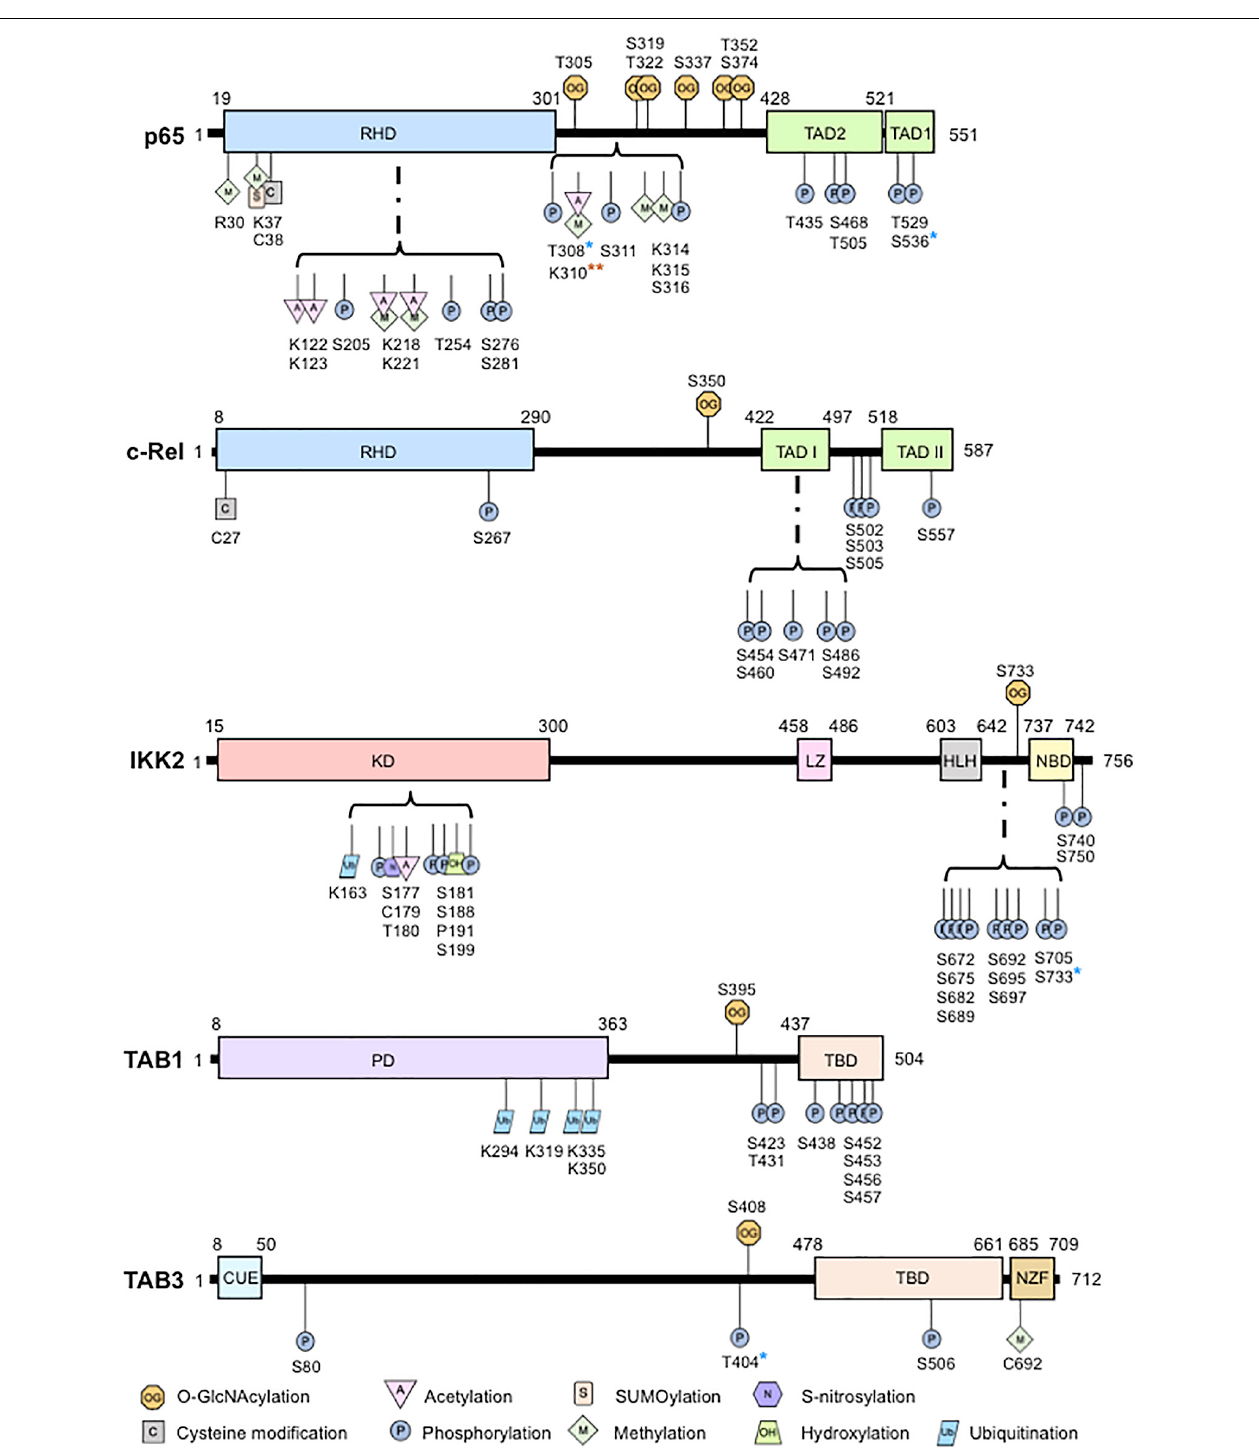
FIGURE 1 | Overview of O -GlcNAcylation sites and other posttranslational modifications in the nuclear factor-kappaB (NF- κ B) pathway proteins. Shown are the principle structural motifs and posttranslational modification sites of p65, c-Rel, IKK2, TAB1, and TAB3. RHD, rel homology domain; TAD, transactivation domain; KD, kinase domain; LZ, leucine zipper; HLH: helix-loop-helix domain, NBD, Nemo-binding domain; PD, pseudophosphatase domain, TBD, TAK1 binding domain; CUE, coupling of ubiquitin conjugation to endoplasmic reticulum degradation; NZF, Npl4 zinc finger. *Activity has been shown to have crosstalk with O -GlcNAcylation; **Site specific acetylation but not methylation at this site has been shown to be related to O -GlcNAcylation.